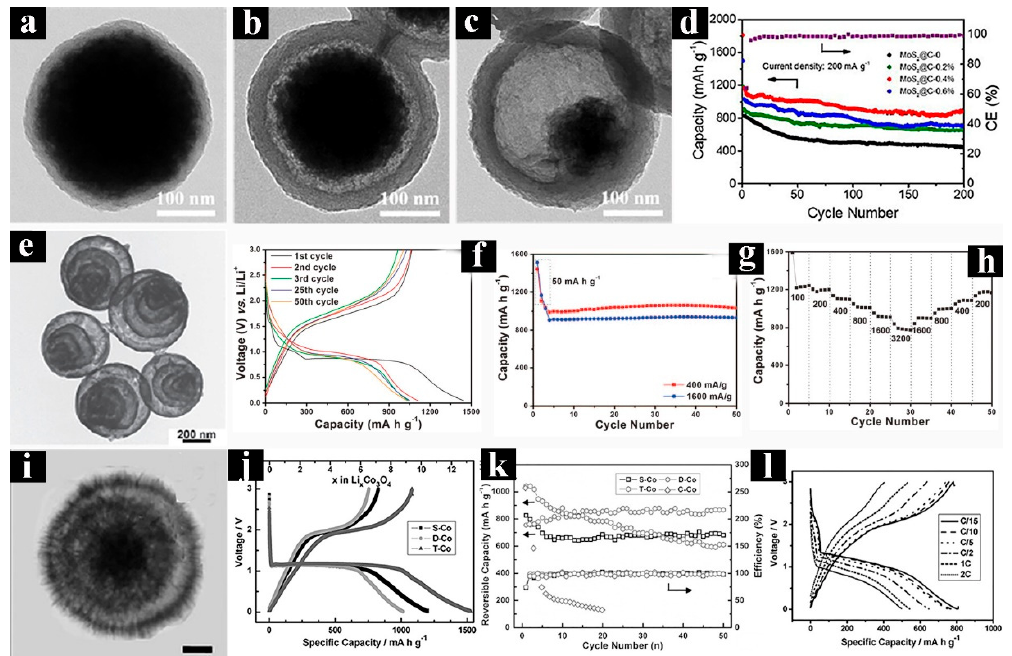
Figure 11. TEM images of yolk-shell and multi-shell spheres and their lithium-ion batteries (LIBs) performance: TEM images of: ( a ) MoS 2 @C-0.2%, ( b ) MoS 2 @C-0.4 %, and ( c ) MoS 2 @C-0.6%